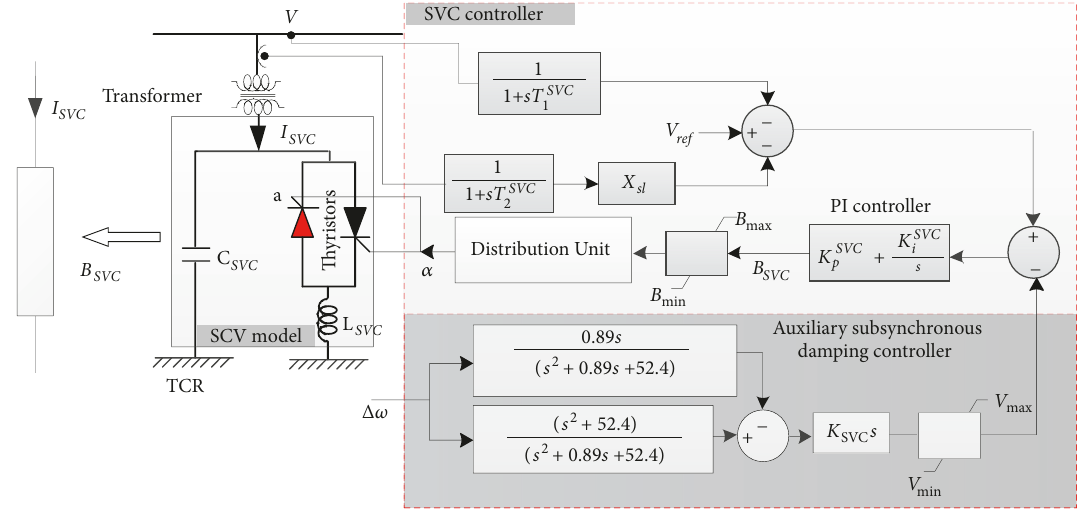
Figure 13: The control strategy for SVC.